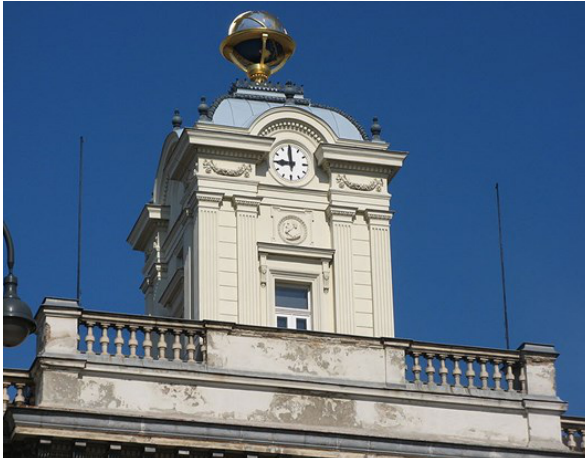
Figure 7. The tower-pavilion of the first Pan-Austrian Military Geographical Institute in Vienna (1842). A round relief portrait below of the clock reminds on Johannes Kepler (1571-1630), the elected patron of the building (Source: BEV)